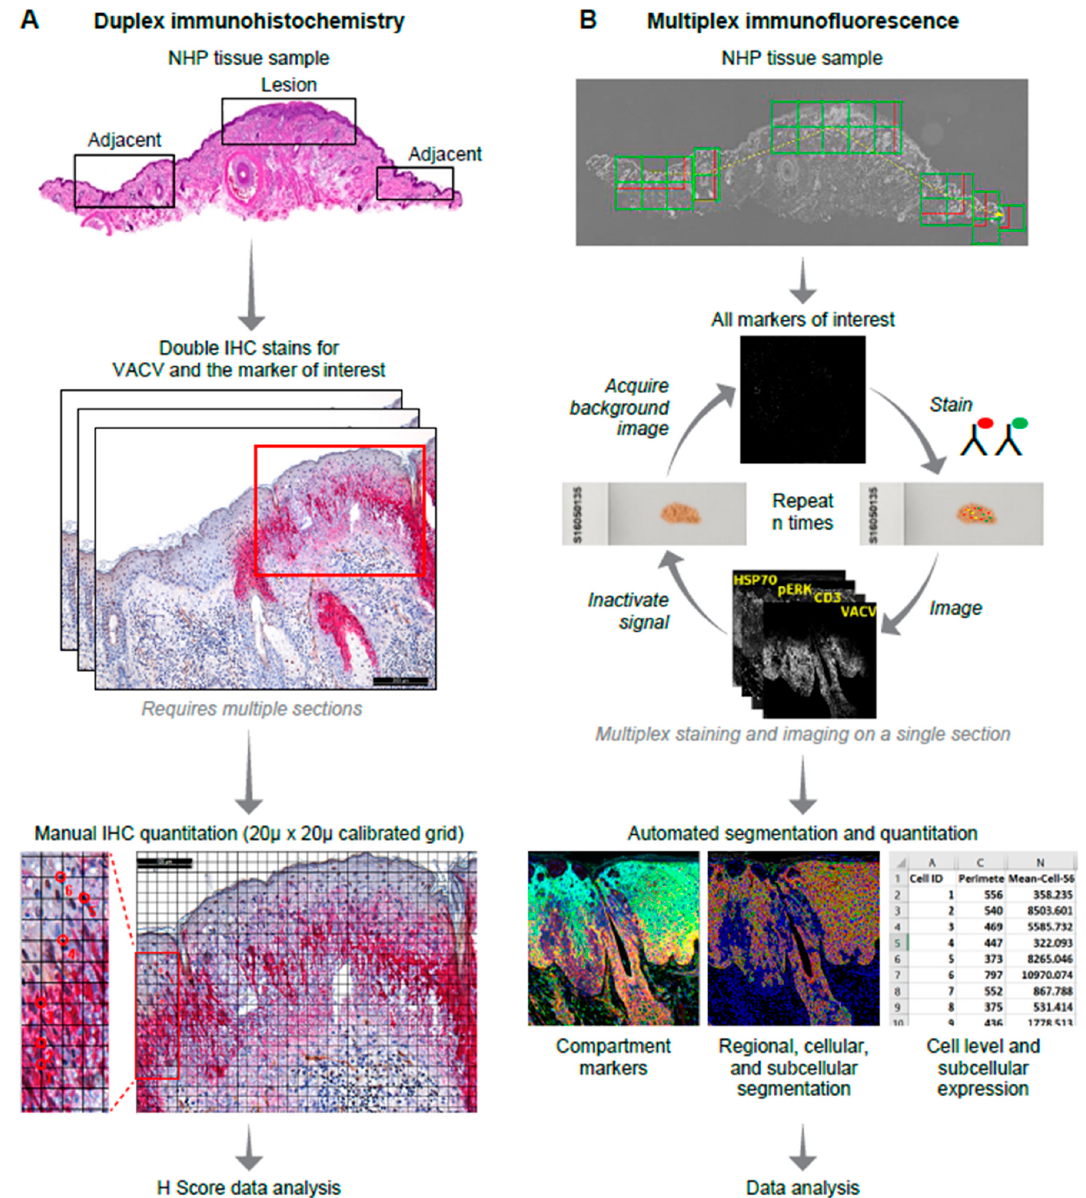
Figure 1. High-level immunohistochemistry (IHC) and multiplex immunofluorescence (MxIF) analysis workflows. Overall, workflows show staining processes and subsequent quantification